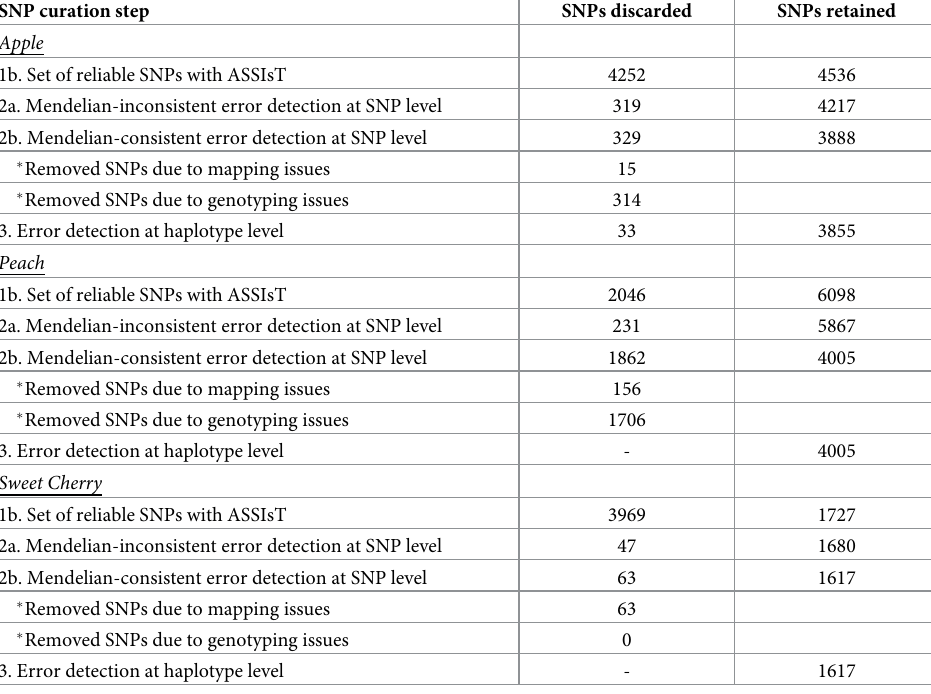
Table 3. Summary of SNPs retained and discarded for apple, peach and sweet cherry during the steps of the